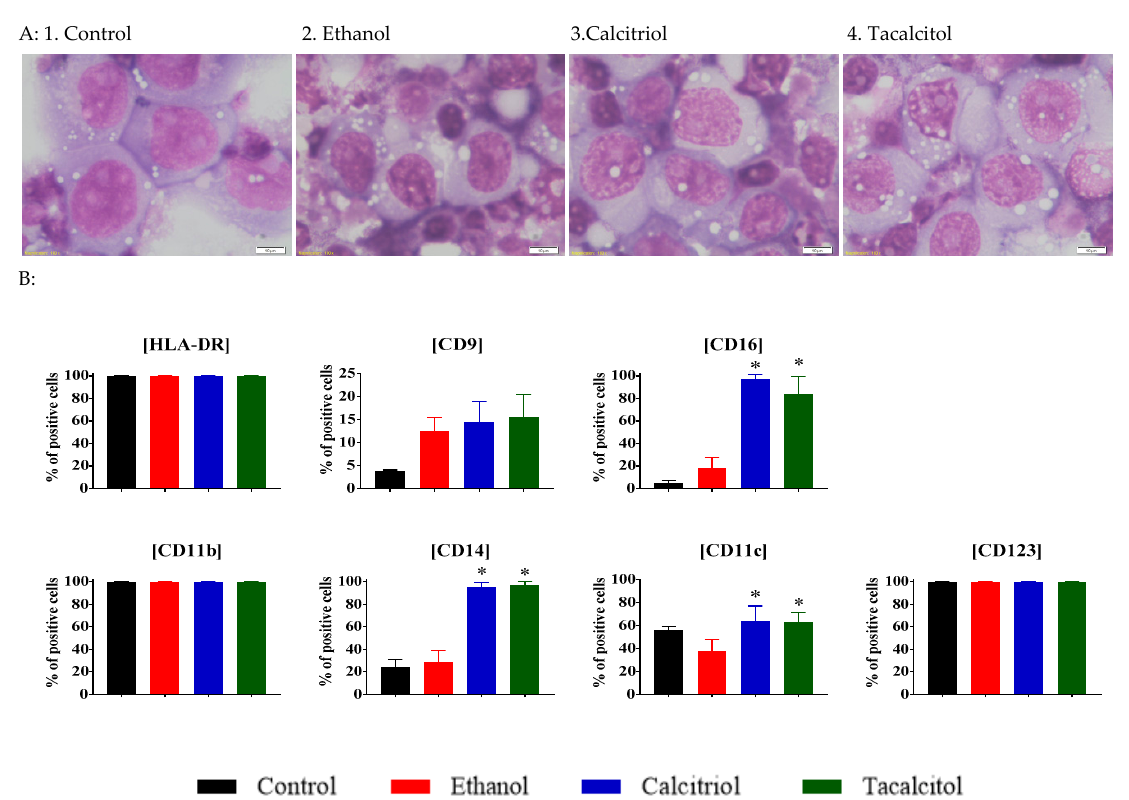
Figure 3. Morphology and differentiation of myeloid-derived iDCs upon calcitriol and tacalcitol treatment: ( A ) May–Grunwald–Giemsa staining; scale bar 10 µ m. Each staining was performed independently twice; ( B ) distribution of differentiation markers by flow cytometry analysis. Mean values and standard deviation are presented. Statistical analysis: Sidak’s multiple comparisons test; significant differences as compared with ethanol (* p < 0.005). The graphs represent data from at least three separate experiments.